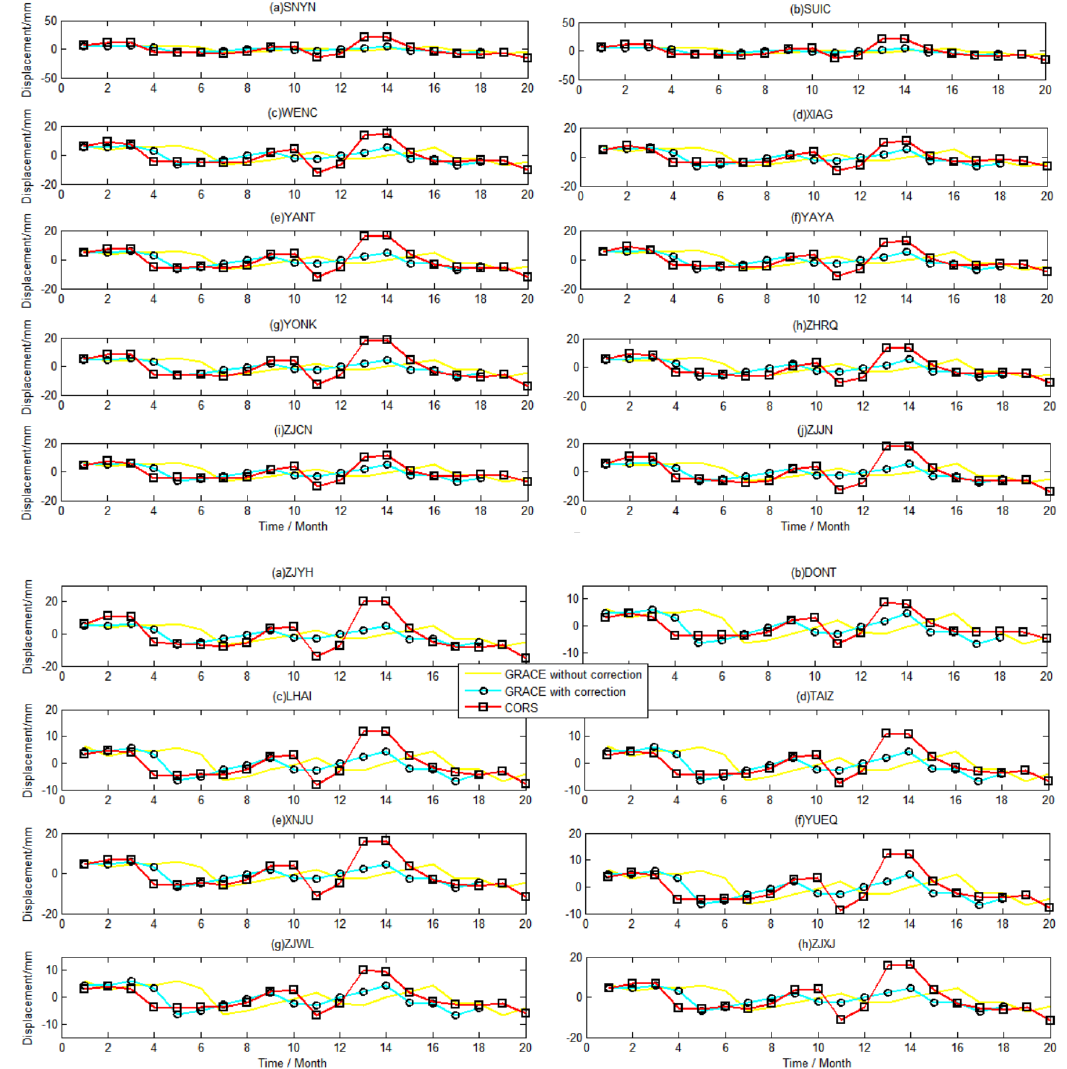
Figure A4. Supplement to Figure